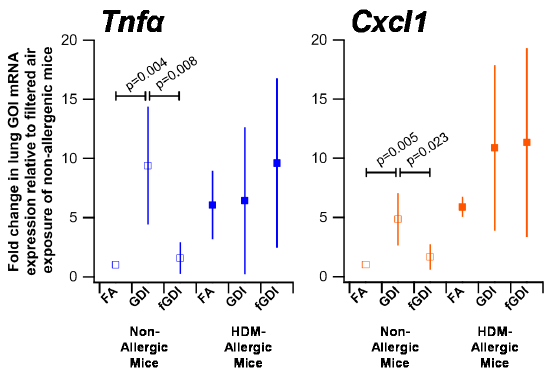
Figure 5. Airway inflammation induced following f-GDI engine exhaust exposure. Cxcl1 and Tnf α mRNA expression was measured in lung homogenates from naïve mice (non-allergic; open squares) and mice with airway hyperresponsiveness (HDM allergic, filled squares) exposed to HEPA filtered air (FA), GDI engine exhaust, or filtered GDI engine exhaust (fGDI). Genes of interest (GOI) transcript expression were normalized to Ppia expression and expressed as a fold change relative to the non-allergic mice exposed to HEPA filtered air (saline-FA). Means ± SDs are shown from 5 mice per group.